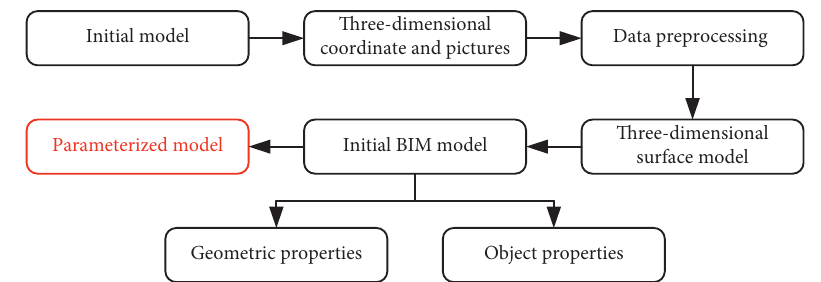
Figure 1: Modeling process of real-time construction model.